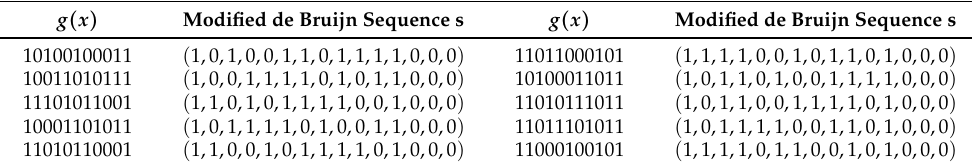
Table 2. Degree 10 polynomials g ( x ) = ∑ 10 in (1) and their corresponding